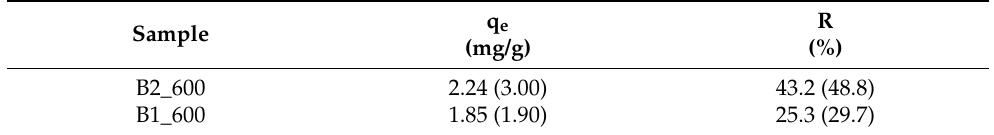
Table 5. Amount of MO adsorbed (mg/g) and final MO rejection (%), due to photocatalytic degrada- tion, after 4 successive cycles (C 0 = 12 ppm, pH = 6, 25 ◦ C) compared to the data obtained from the first cycle (values in